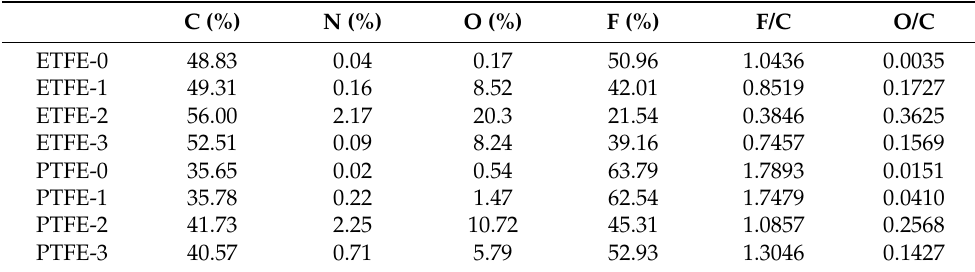
Figure 5. XPS spectra of membrane surface before and after treatment: ( a ) ETFE membrane and ( b ) PTFE membrane. Table 2. Percentage of elemental content of ETFE and PTFE membranes before and after surface